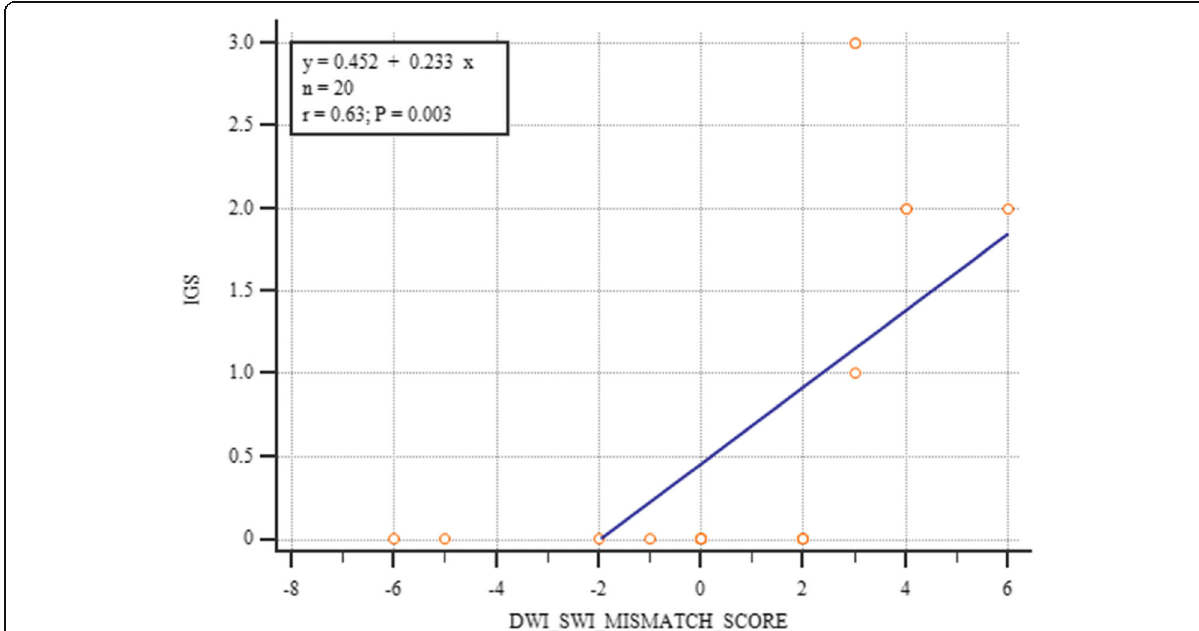
Fig. 4 Correlation between DWI/SWI mismatch and IG scores. There was a significant positive correlation between DWI/SWI mismatch and IG scores ( n = 20, r s = 0.788, p = 0.000